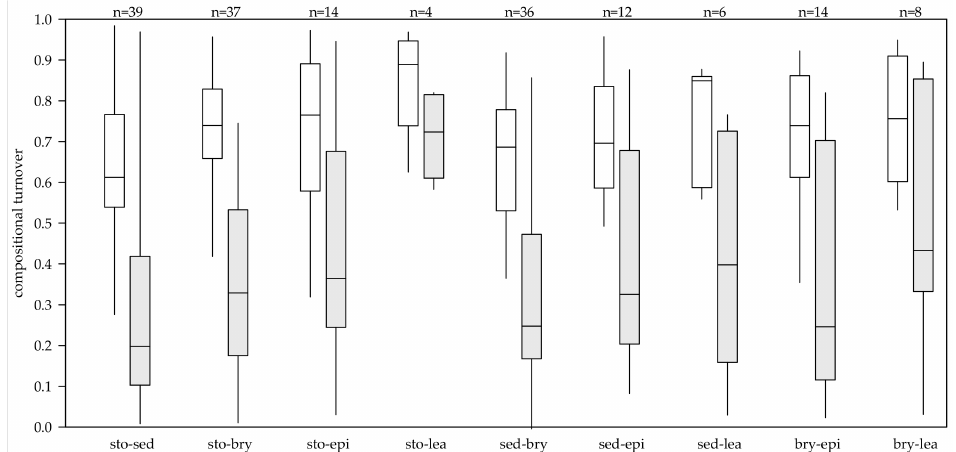
Figure 2. Compositional turnover between di ff erent substrates within the same spring calculated with the Jaccard similarity coe ffi cient. White boxes show the similarity between counted samples where only counted abundances were considered. Gray boxes show the similarity between estimated samples where species richness was estimated according using the Chao similarity coe ffi cient. Substrates: Bry = Bryophytes, Sed = Sediment, Sto = Stones, epi = epiphytic on filamentous green-algae, lea = leaf litter, all = cumulative species richness of all substrates at the site. The lower edge of the grey boxes shows the 1st quartile, the upper edge the 3rd quartile, and the line in boxes shows the